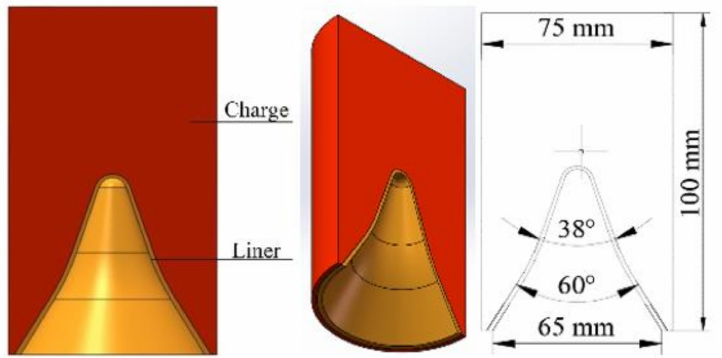
Figure 1. Structure of the shaped charge